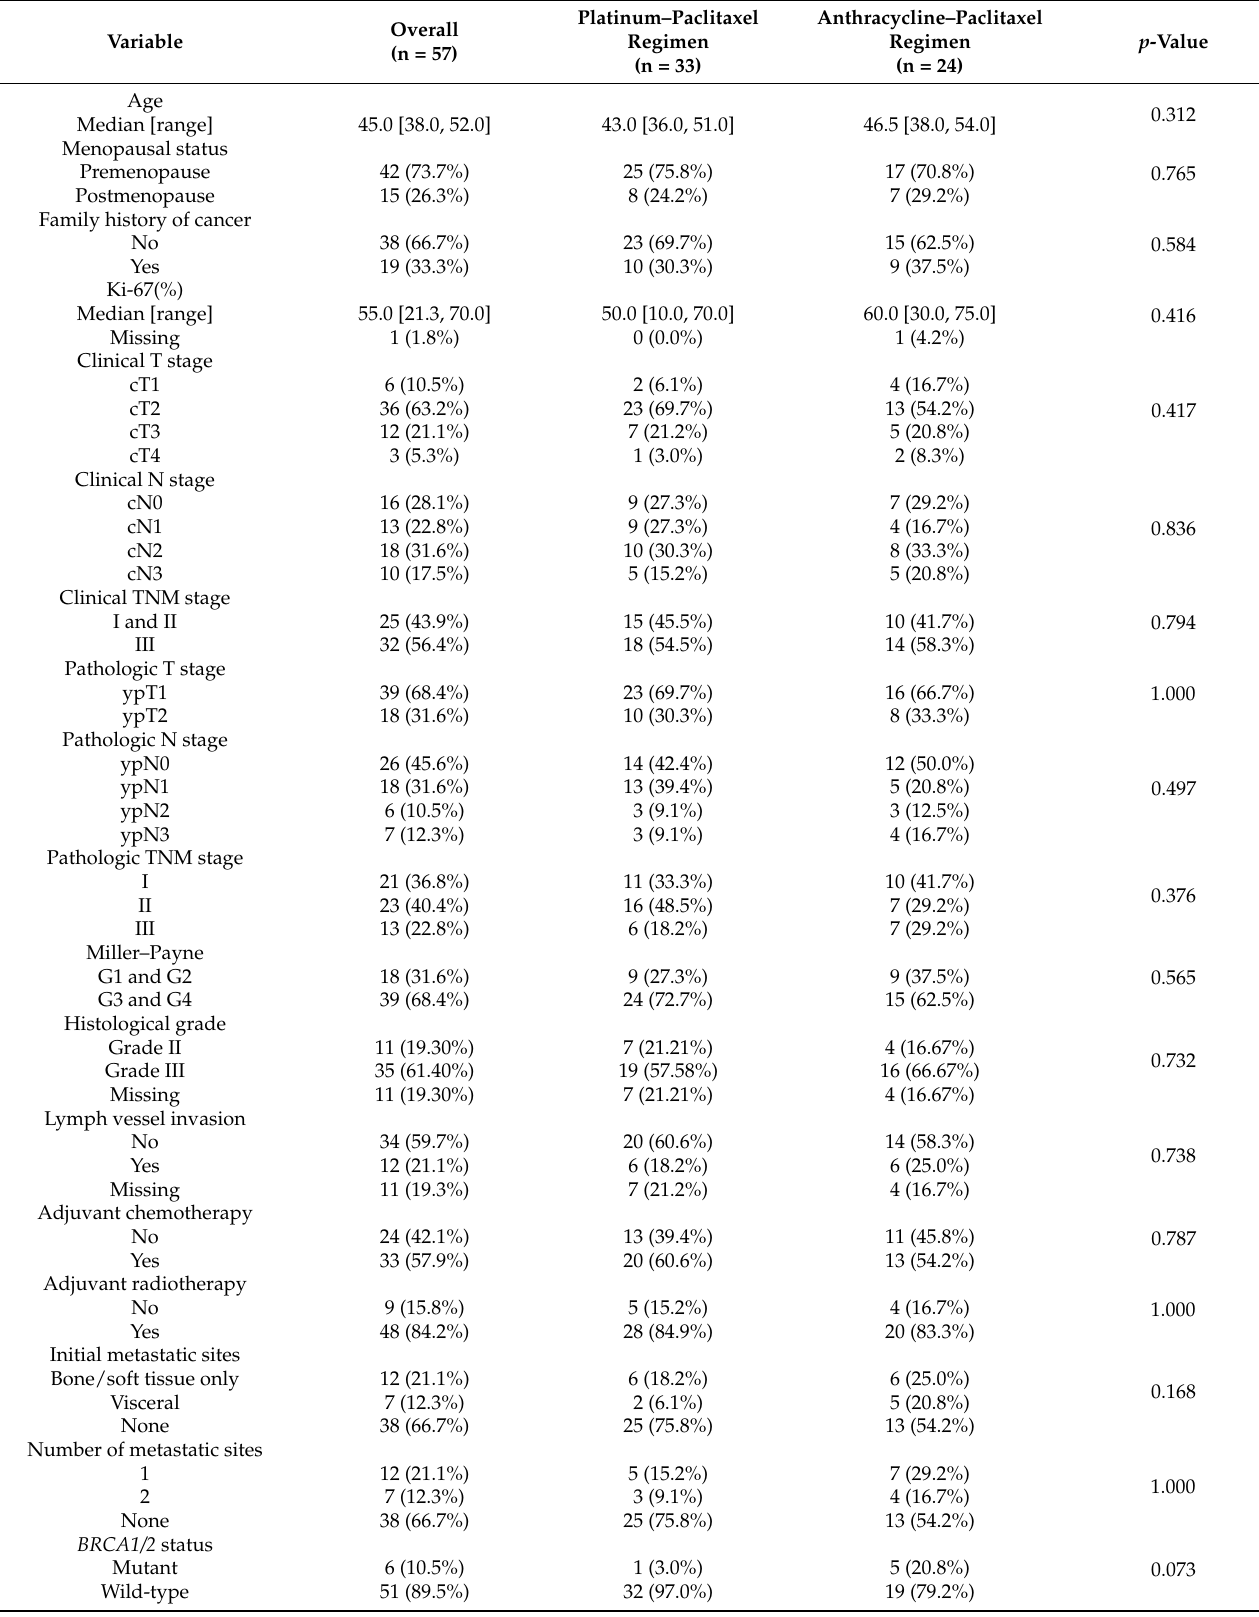
Table 1. Baseline characteristics and treatment outcomes of the overall cohort and treatment sub-